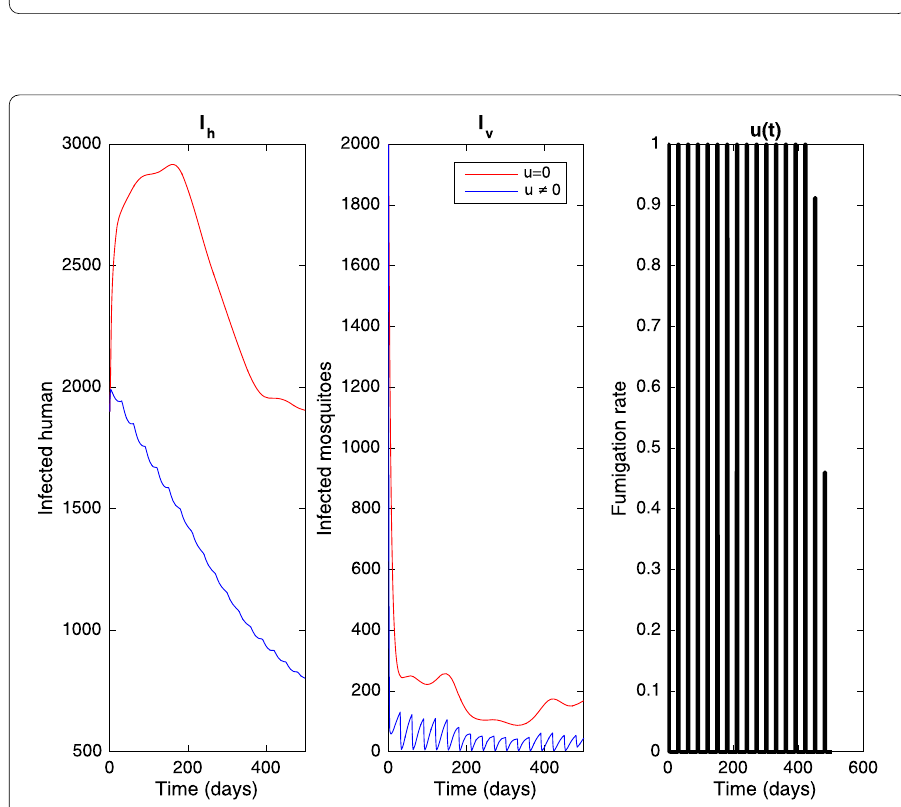
Figure 13 Numerical simulation results with and without fumigation in cases of nonseasonal influence